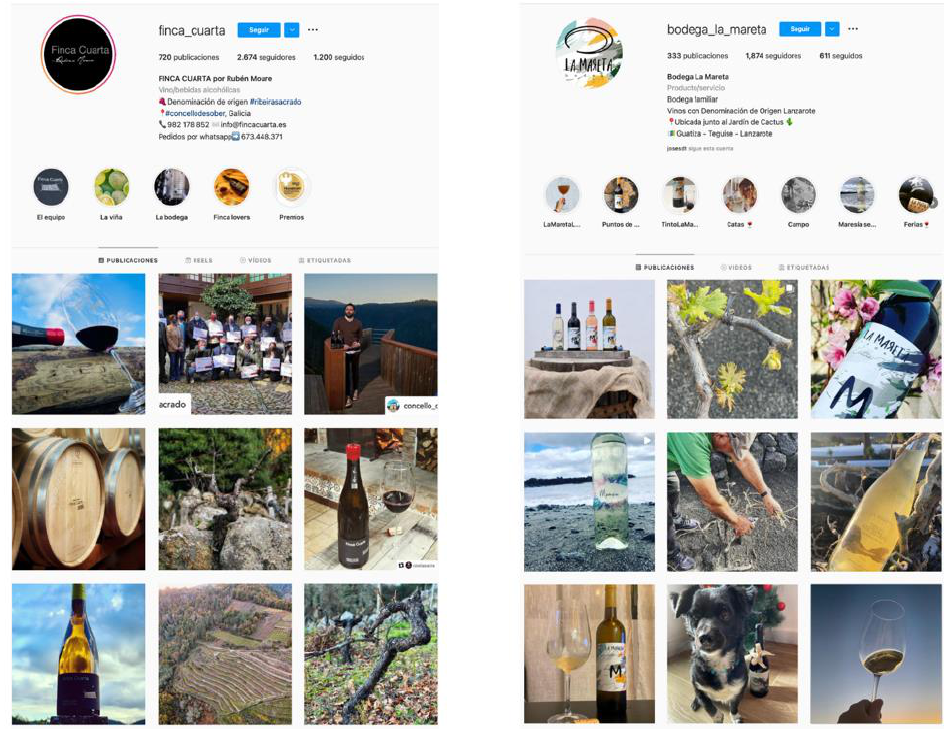
Figure 5. Example of Instagram use by wineries from the Ribeira Sacra and Lanzarote AOs. Source: Own elaboration based on publications made by the wineries studied on Instagram.